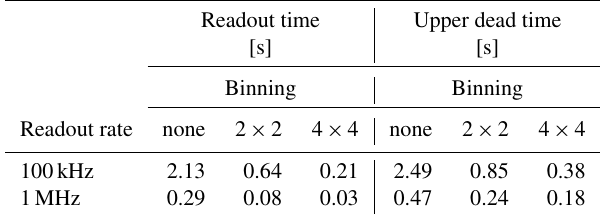
Table A2. Left: CCD readout time as returned by the camera soft- ware representing theoretical lowest dead time values. Right: exper- imentally derived upper dead time limits (recommended settings). For the measurement the amplifier was run in low noise mode and we used the default camera